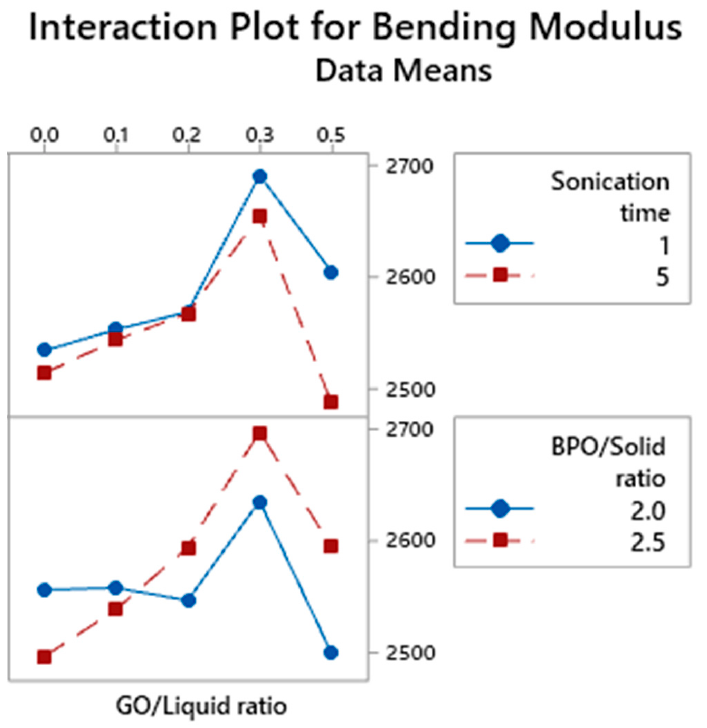
Figure 9. Interaction plot between the effect sonication time vs. GO/liquid ratio and BPO/solid ratio vs. GO/liquid ratio for the Bending variable modulus.